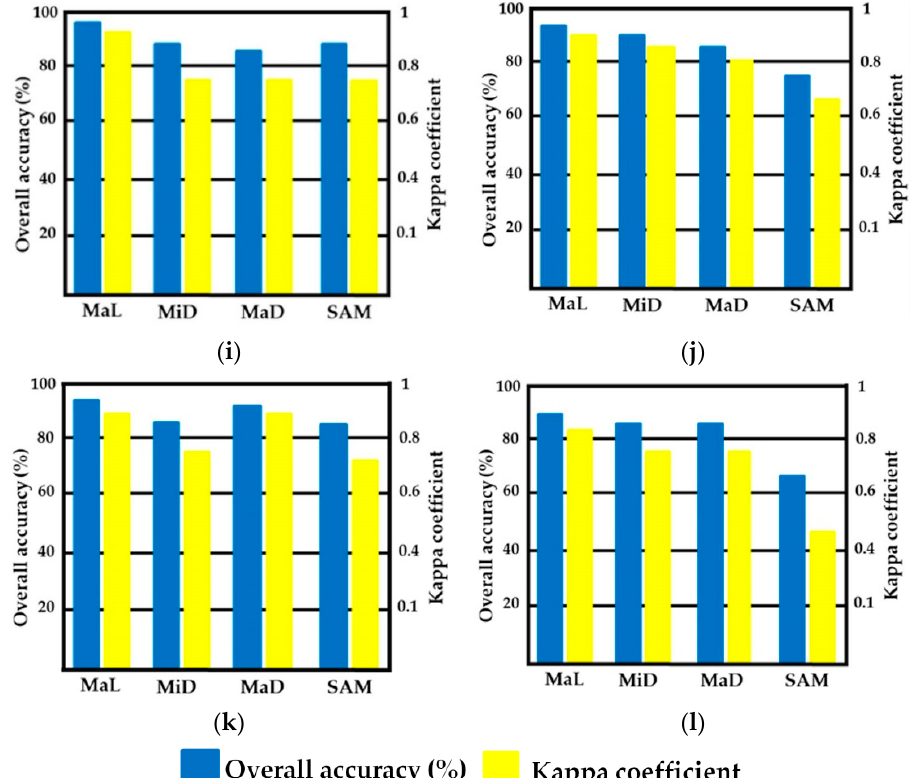
Figure 6. Performance of maximum likelihood (MaL), minimum distance (MiD), mahalanobis distance (MaD) and spectral angle mapper (SAM) classification methods for the PBs of Messina province, with OA and kappa coefficient for South Isola Bella (SIC01ME01), North Isola Bella (SIC01ME02), and Mazzarò (SIC02ME03) PBs located on the coast of Taormina ( a ); OA and kappa coefficient for three PBs of East (SIC03ME04), North (SIC03ME05), and West (SIC03ME06) located along the coast of Milazzo ( b ); OA and kappa coefficient for the Patti–Tindari’s PBs East (SIC04ME07), Center (SIC04ME08), and West (SIC04ME09) ( c ); OA and kappa coefficient for the two PBs of East Capo Calavà (SIC05ME10) and West Capo Calavà (SIC06ME11) on the coast of Gioiosa Marea ( d ); OA and kappa coefficient for the PB of Lipari-La Forbice (SIC09ME14) ( e ); OA and kappa coefficient for the PB of Lipari—Pignataro di Fuori (SIC10ME15) ( f ); OA and kappa coefficient for the two PBs of Lipari—Sabbie Bianche (SIC11ME16) and Lipari—Lido Blu (SIC12ME17) located on the east coast of Lipari ( g ); OA and kappa coefficient for the two PBs of Volcano Island, Punta dell’Asino (SIC07ME12) and Punta Bandiera (SIC08ME13) ( h ); OA and kappa coefficient for four PBs of Zimmaro (SIC15ME20), West Preistorico (SIC16ME21), and Central Preistorico (SIC16ME22) of Panarea Island ( i ); OA and kappa coefficient for one PB of Filicudi—Le Punte (SIC17ME24) ( j ); OA and kappa coefficient for one PB of Punta Scario (SIC13ME18) located on the coast of Malfa on Salina Island ( k ); and OA and kappa coefficient for one PB of Pollara (SIC14ME19) located on the coast of Malfa ( l ).